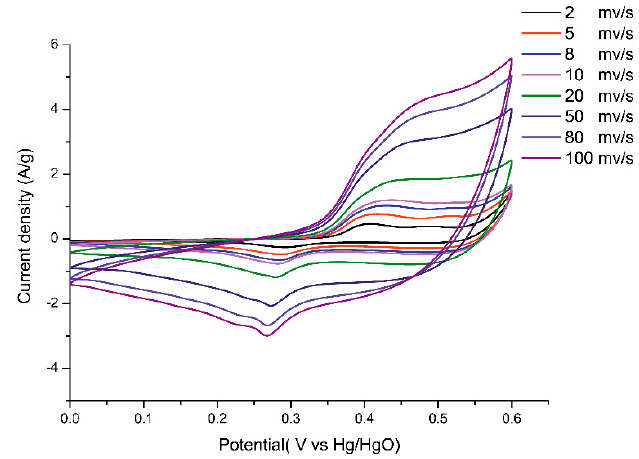
Figure 3. Cyclic voltammetry (CV) curves of the Ni@Cu-MOF at scan rates 2, 5, 8, 10, 20, 50, 80, and 100 mV s − 1.